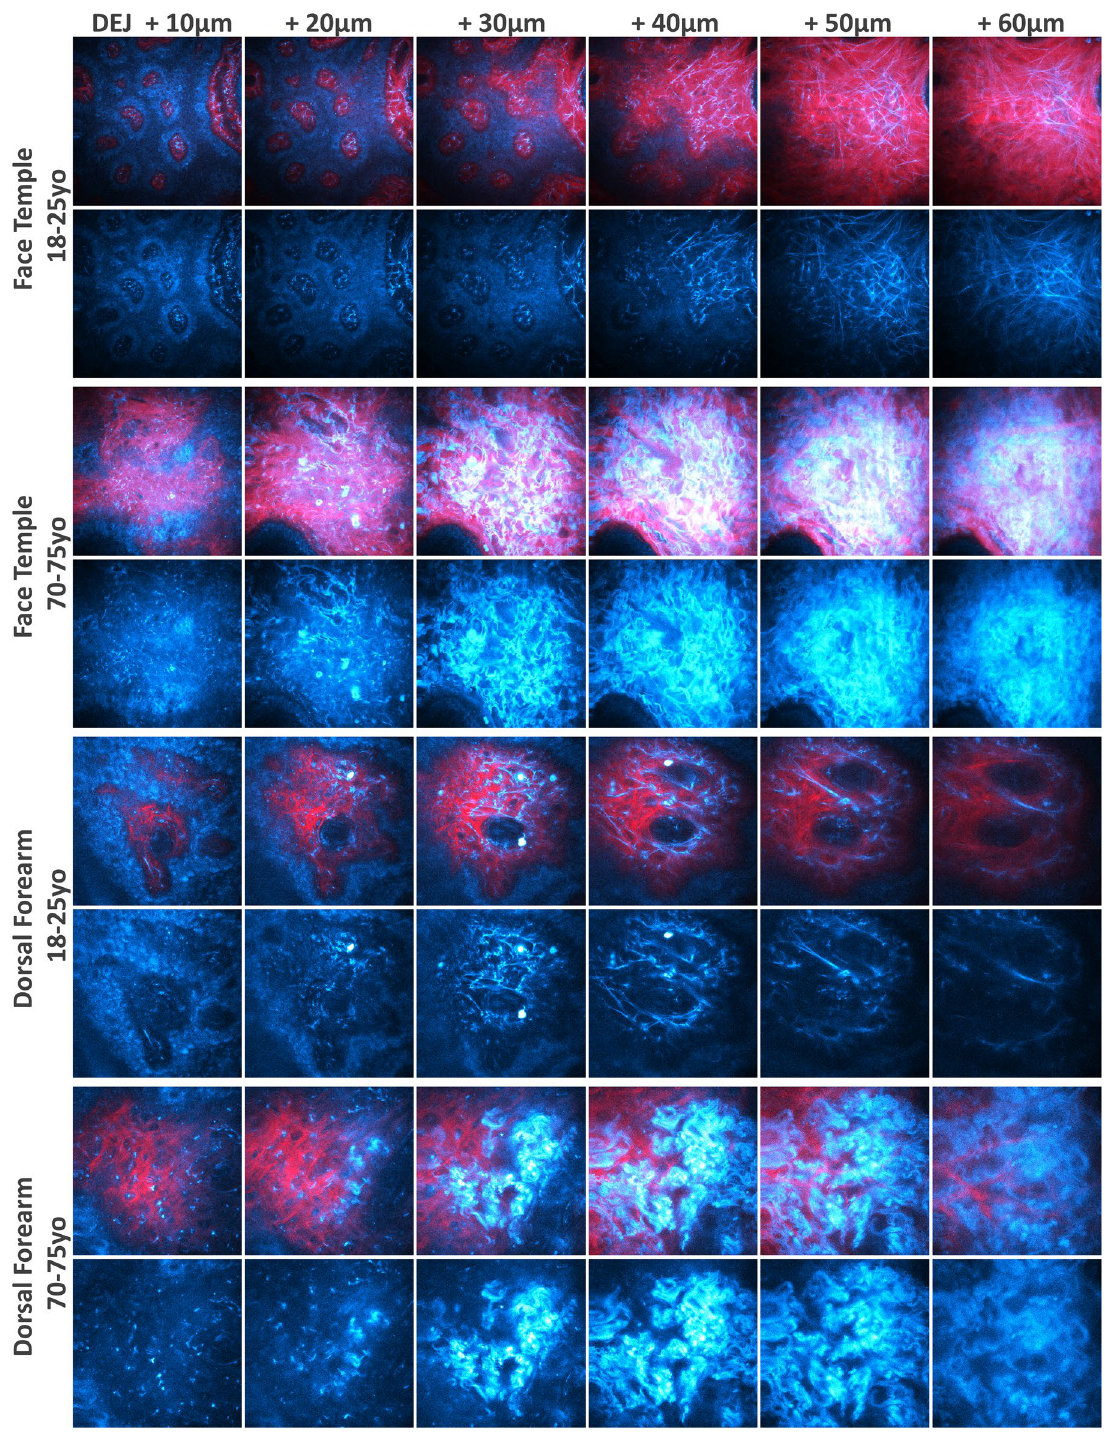
Figure 6. In vivo multiphoton images of dorsal forearm and face temple areas showing elastin aging changes. Representative multiphoton 2PEF (cyan hot—cells and elastin) and SHG (red—fibrillar collagens) images acquired at different depths from the DEJ interface of young (18–25 year-old) and old (70–75 year-old) volunteers. (top) face temple (clinical study III, MPT flex , 204 × 204 µm 2 ); (bottom) dorsal forearm (clinical study II, DermaInspect, 130 × 130 µm 2 ). In young volunteers, elastin 2PEF signal maps the distribution of thin and mostly straight elastic fibers, whereas in old volunteers, thicker and more undulated elastic fibers appear along with abnormal deposits of elastin referred to as solar